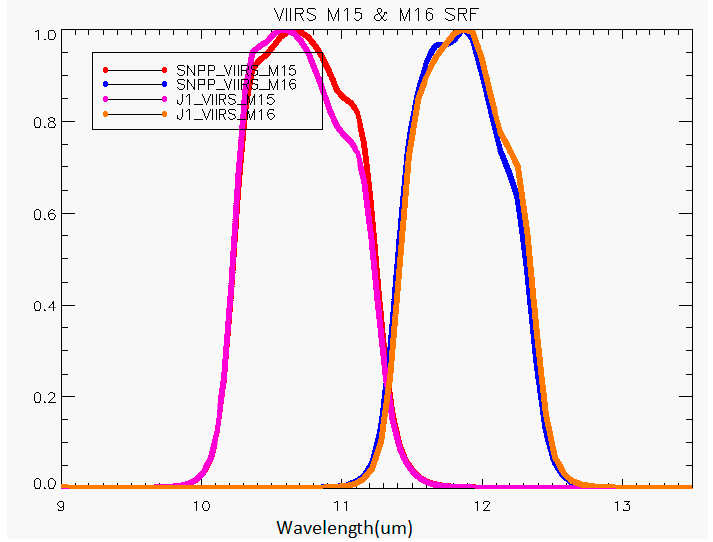
Figure 1. The spectral response function of band 15 and 16 of VIIRS onboard Suomi National Polar- Orbiting Partnership (S-NPP) and N20 satellite (shown as J1 in the